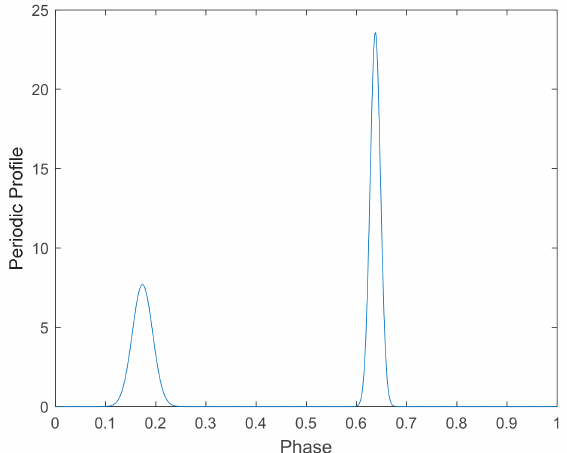
Figure 3. Profile of PSR B1821-24.